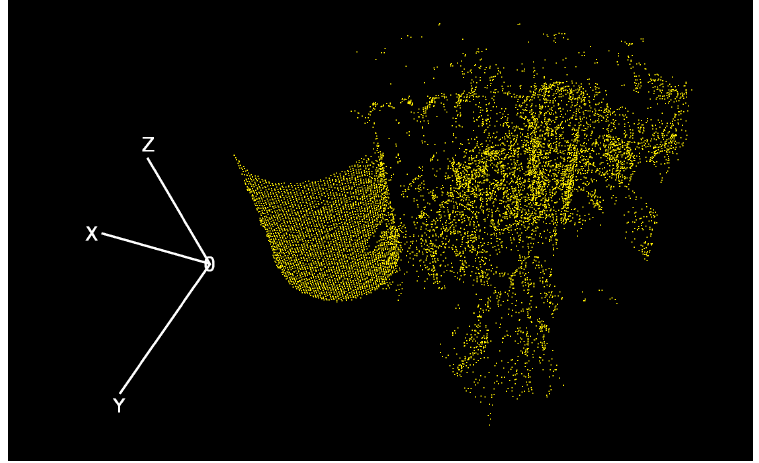
Figure 2. TLS data points cut out at 1.0–1.5 m above ground: To the left part of a tree stem and to the right part of a small tree with dense